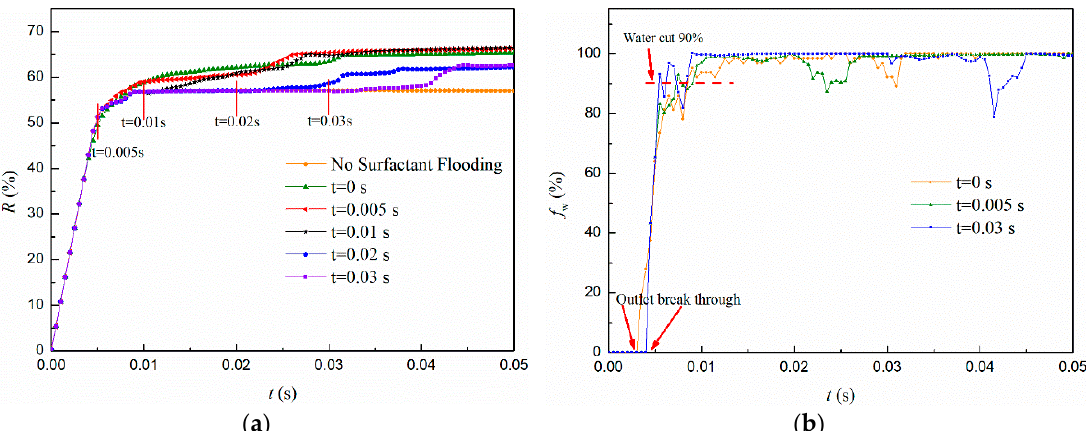
Figure 9. The oil recovery and water cut at the outlet when the surfactant is injected at different times: ( a ) oil recovery rates (Y-axis is oil recovery rate, % and X-axis is time, s) and ( b ) water cut curves (Y-axis is water cut, % and X-axis is time, s).